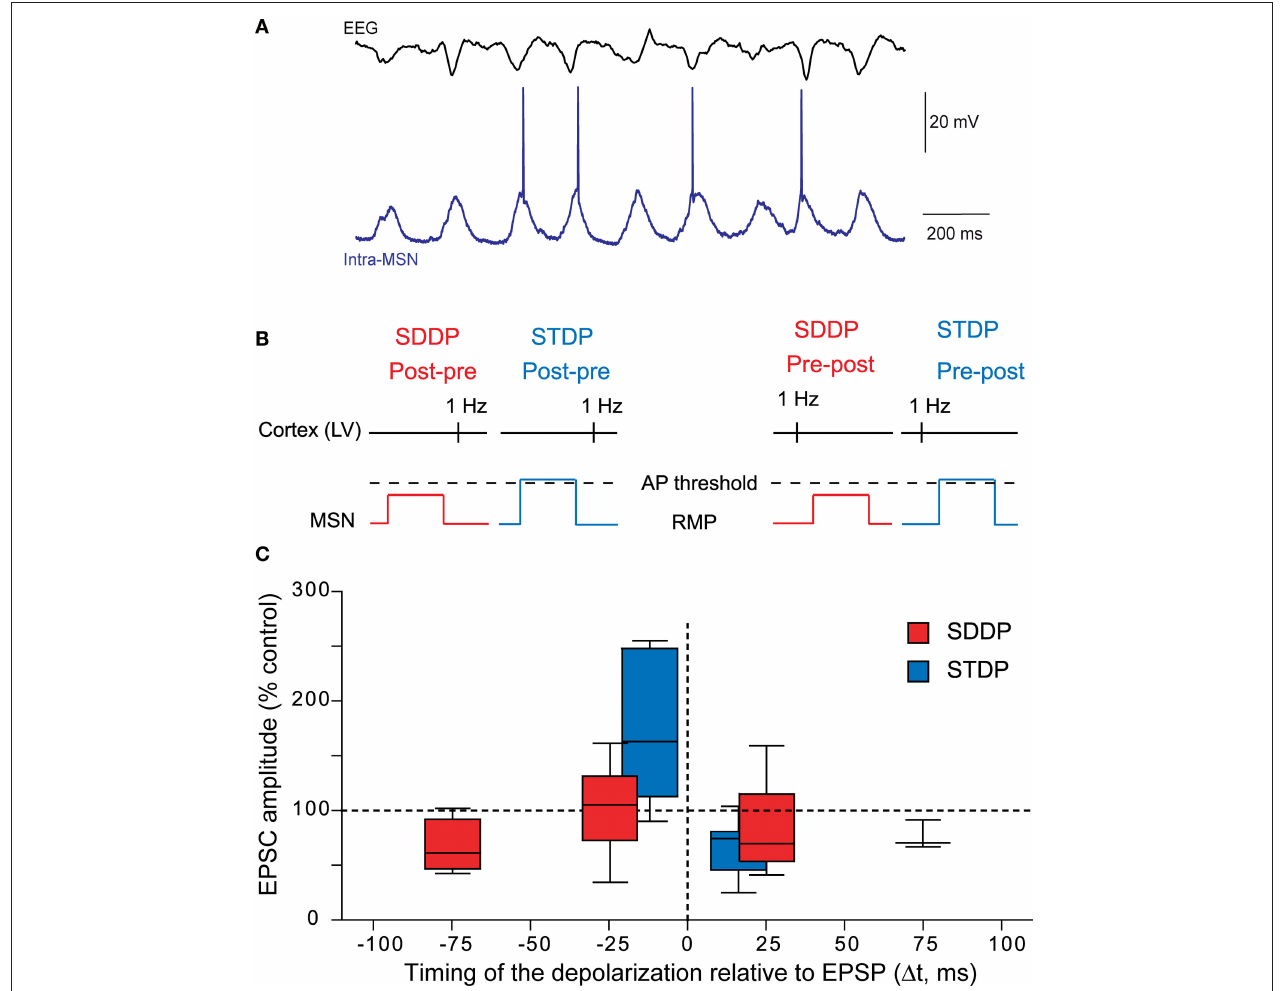
FiGure 6 | Beyond the action potential, the subthreshold-depolarization dependent plasticity. (A) In vivo simultaneous recordings of the EEG of the cortical activity and the intracellular recording of one MSN. Synchronous cortical activity triggers action potentials in the MSN but also leads to subthreshold events (Adapted from Mahon et al., 2001). (B) Schematic representations of post-pre and pre-post SDDP and STDP protocols (the two protocols differ by the